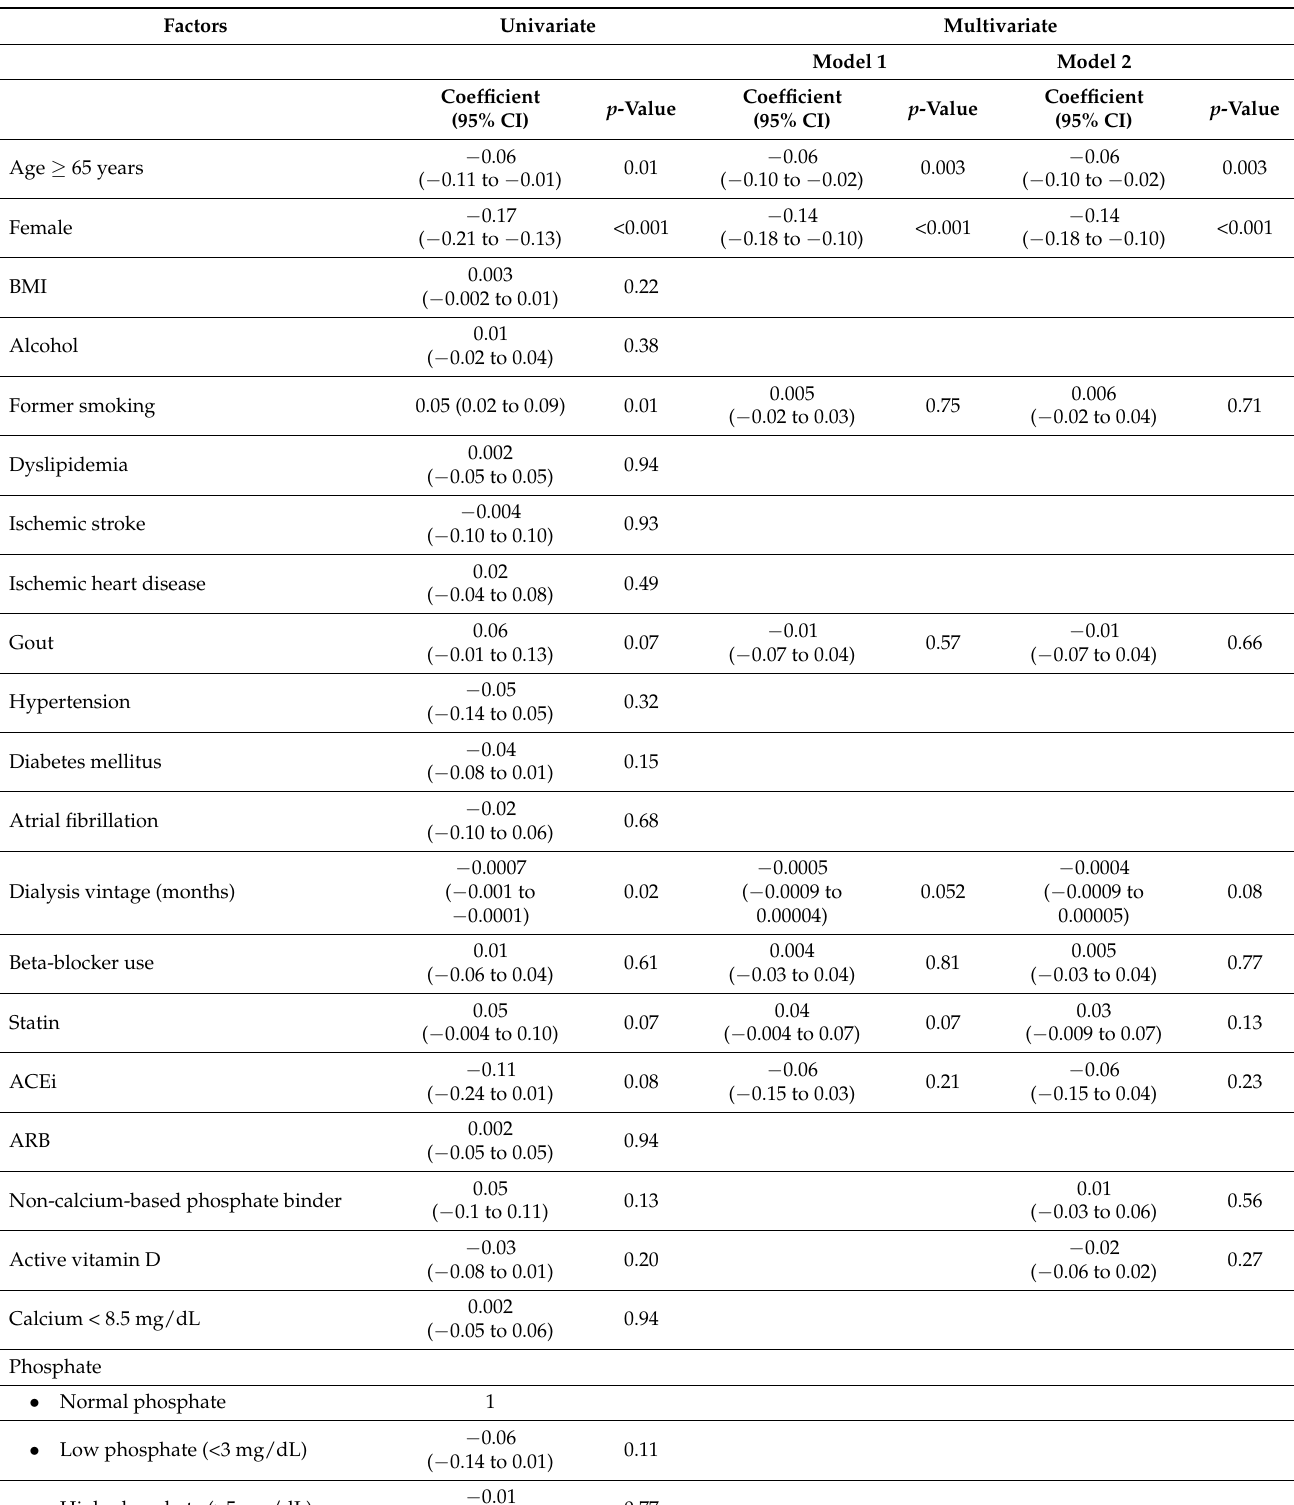
Table 4. Association of beta-blocker use and BMD of the 1/3